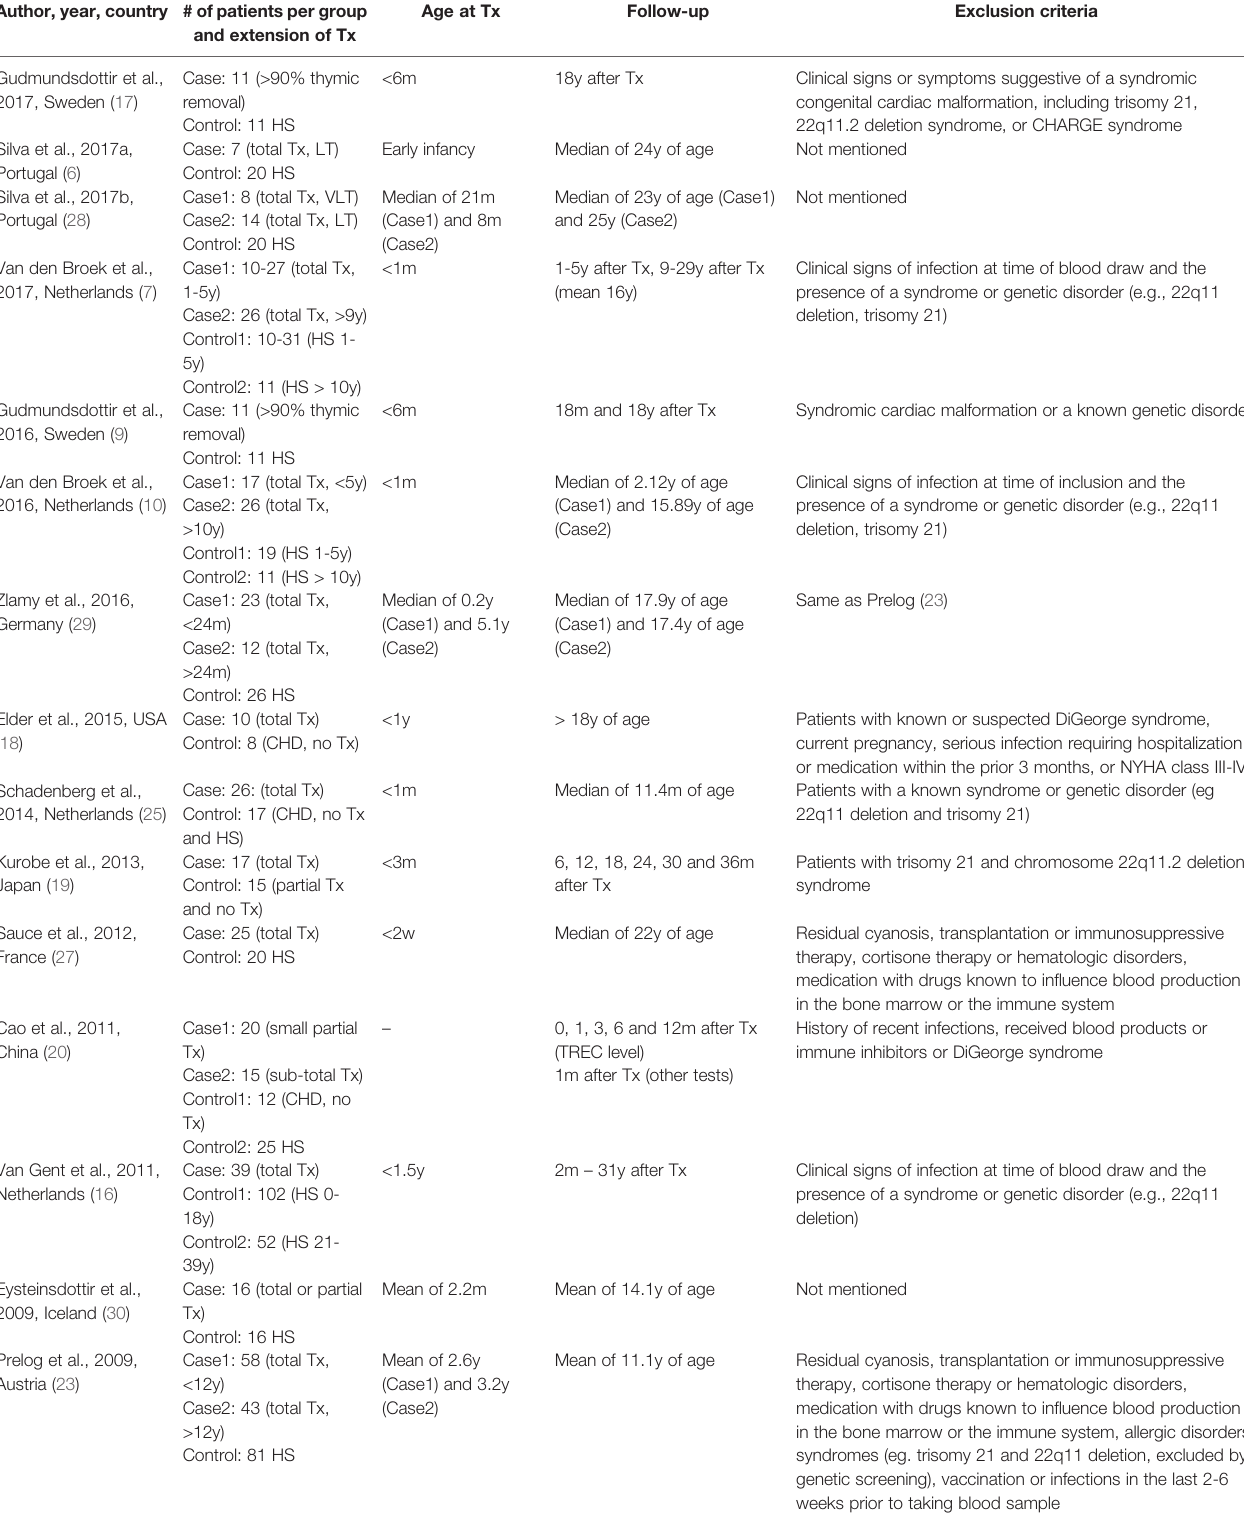
TABLE 1 | Main characteristics of included